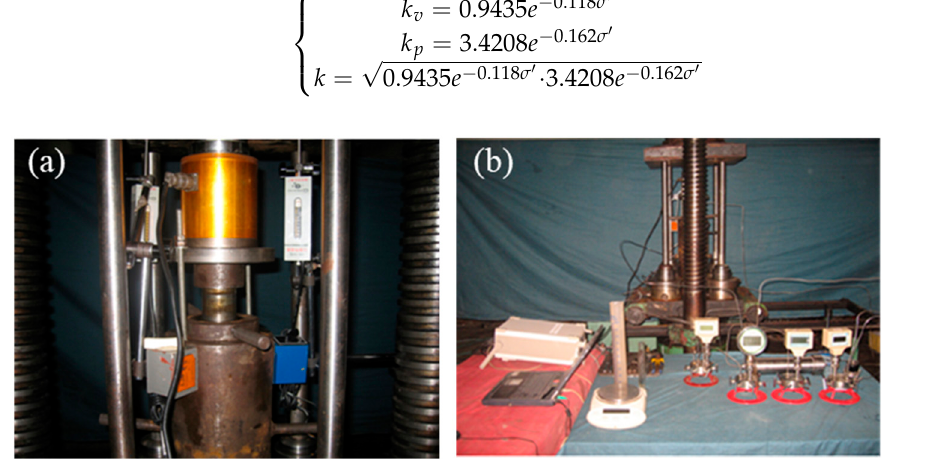
Figure 2. The coal seam permeability test device in the laboratory: ( a ) is the seepage device and ( b ) is other accessories of the equipment.